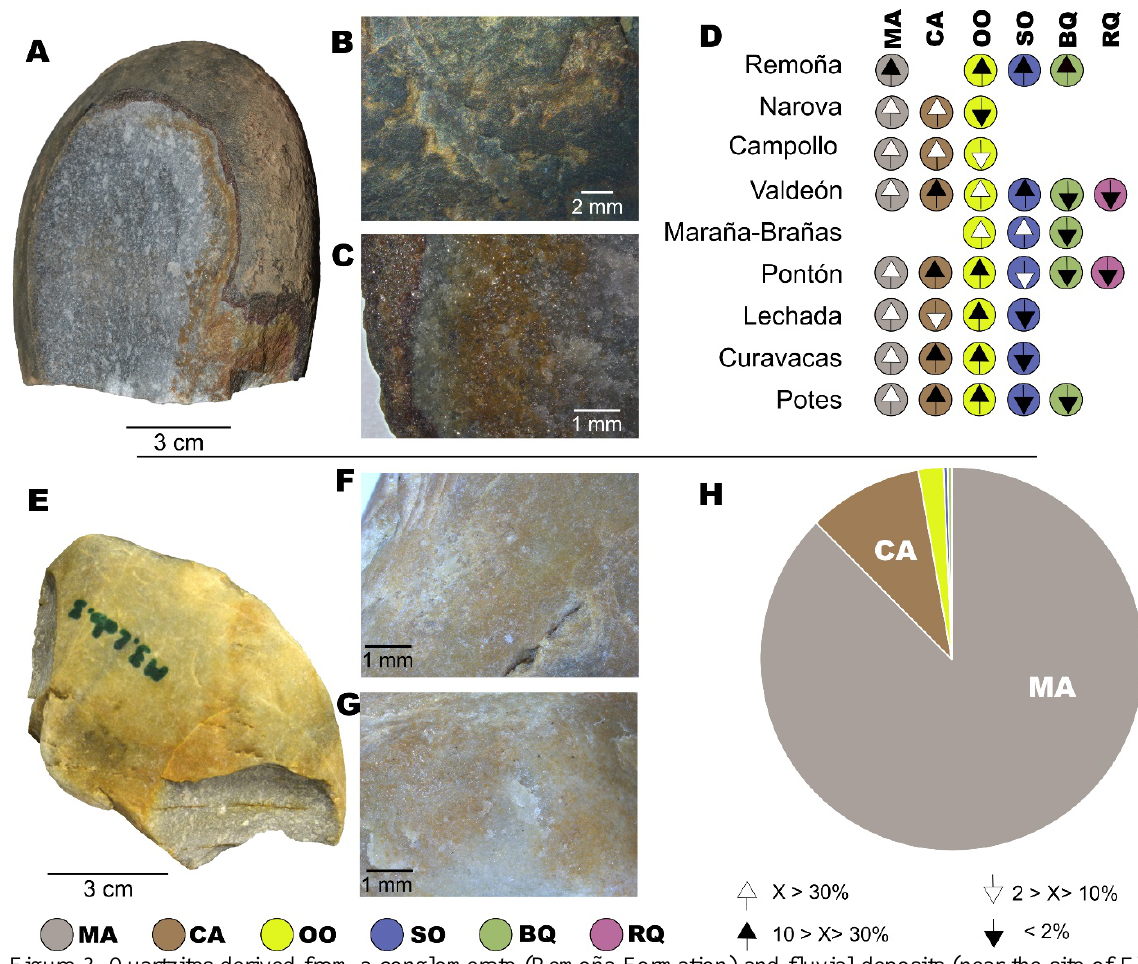
Figure 3. Quartzites derived from a conglomerate (Remoña Formation) and fluvial deposits (near the site of El Esquilleu). The first is a SO type and the second an OO orthoquartzite (A and E). Different textures are observable. The first is rougher than the second, mainly due to cement, making the outer cortical areas darker. Details of representative cortical surfaces: B) conglomerate cement (dark with iron oxides and pyrite) adhered to the neo-cortical surface (black and thin). C) Inner area of the SO orthoquartzite. From left to right, the weathered area of the quartzite (neo-cortex) in contact with the conglomerate cement; the inner area of the quartzite with iron oxides and pyrite crystals inner rim following external morphology of the pebble. The inner area of the quartzite is less weathered. F) Cortical area of the quartzite displaying impact cracks caused by rock impacts in water courses. See also the void generated by water highlighted by the joint system. G) Plain and polished surface of the cortex (soapy texture). D) Representation of the types of quartzite in interesting conglomerate strata. H) Pie chart of quartzites in fluvial deposits, based on Prieto et al . 2021b). Arrows pointing up and down indicate relative percentage of each petrological